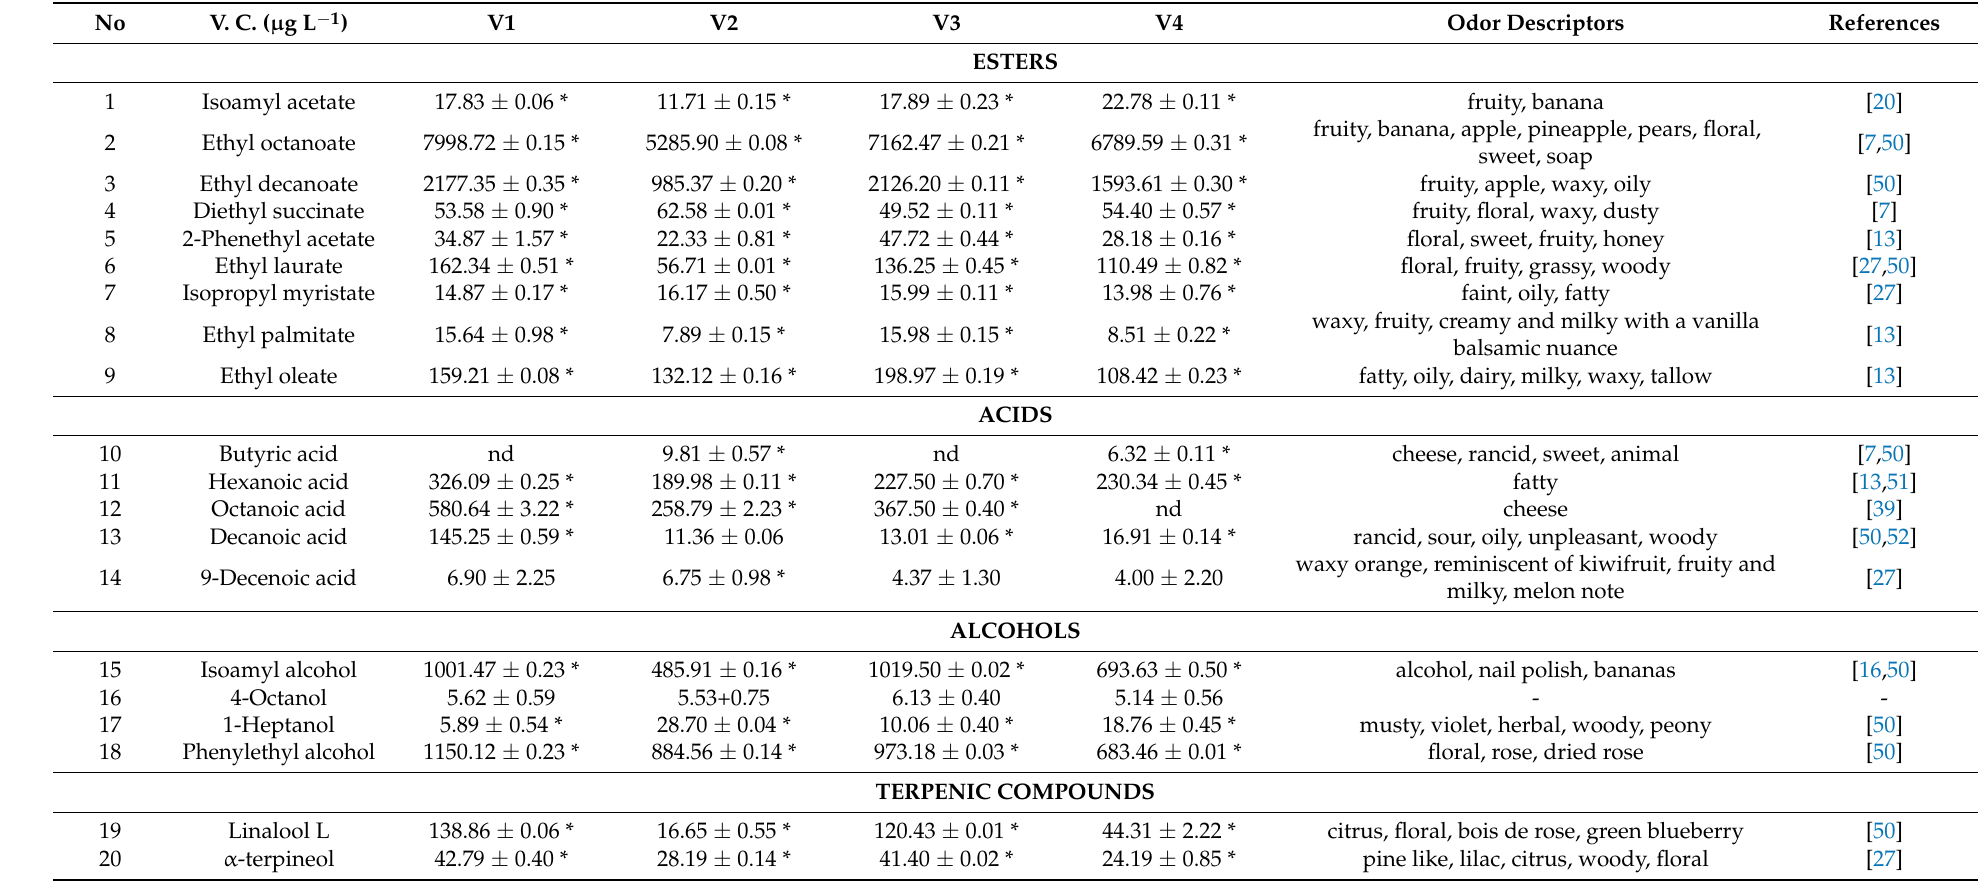
Table 2. Volatile fraction of resulted sparkling